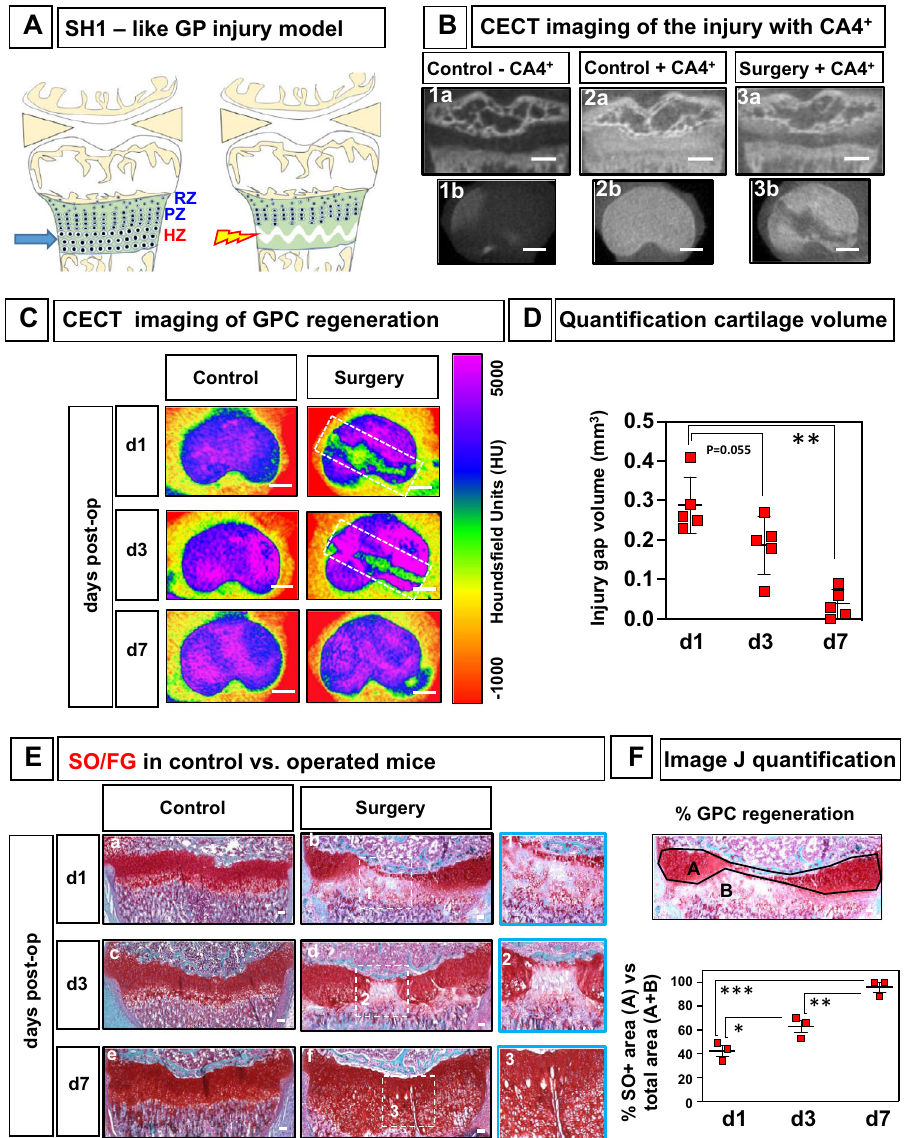
Fig. 6 A murine model of GP injury. A Schematics of Salter – Harris type 1 (SH1)-like injury model. B CECT (contrast-enhanced computed tomography) imaging of the SH1-like injury, 1-day after surgery. Representative sagittal ( 1a , 2a , 3a ) and transverse ( 1b , 2b , 3b ) μ CT slices of the proximal tibia, at 1-day post-surgery, before ( 1a , 1b ) and after ( 2a , 2b , 3a , 3b ) exposure to CA4 + . Scale bars, 500 µ m. C Color maps of representative contrast-enhanced μ CT images of control and operated tibias at 1, 3, and 7 days post-operation, viewed from the transverse plane. The color scale corresponds to Houns fi eld Units (HU). For reference, air attenuates at − 1000 H and water at 0 HU. Scale bars, 500 µ m. D Quanti fi cation of the injury gap volume using CECT imaging. Data are presented as mean ± SD, n = 5 mice for each time point ( d1 , d3 , d7 )). The asterisks indicate signi fi cant difference: Two-tailed Student ’ s unpaired samples t test; ** p = 0.0079 ( d1 vs d7 ). E SafraninO/Fast Green staining of control and operated tibias, 1 day ( a , b ), 3 days ( c , d ), and 7 days ( e , f ) after SH1-like surgery. Inset, central area of the defect (1 – 3). Scale bars, 100 µ m. F ImageJ quanti fi cation of the injury. A is healthy cartilage area (SafraninO + ), B is injured area (SafraninO − ), and A + B is the total area. Percentage (%) cartilage regeneration is A/A + B. Data are presented as mean ± SD, n = 3 mice. The asterisks indicate signi fi cant difference: Two-tailed Student ’ s unpaired samples t test; *** p = 0.000839 ( d1 vs d7 ), ** p = 0.007121 ( d3 vs d7 ), * p = 0.037861 ( d1 vs d3 ). Complete statistical information is provided in Supplementary Table